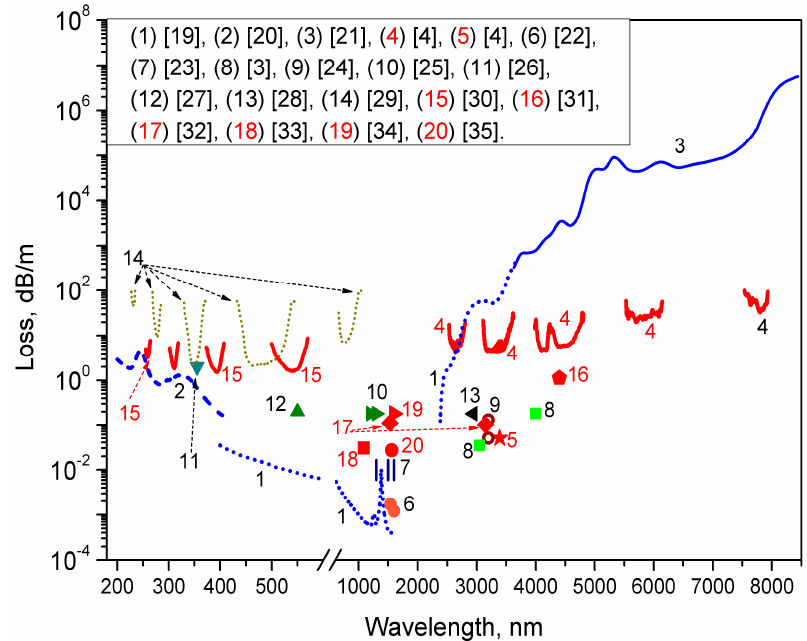
Figure 3. Optical loss in pure silica glass (F300, Heraeus, Hanau, Germany) (blue curves, 1–3) and the minimal optical loss obtained to date in different types of silica glass hollow-core fibers (HCFs). Data on RFs is highlighted in red. In the figure legend, the plotted experimental data are indexed by numbers in round brackets followed by references to literature in square brackets. More details are given in the text [19–35].